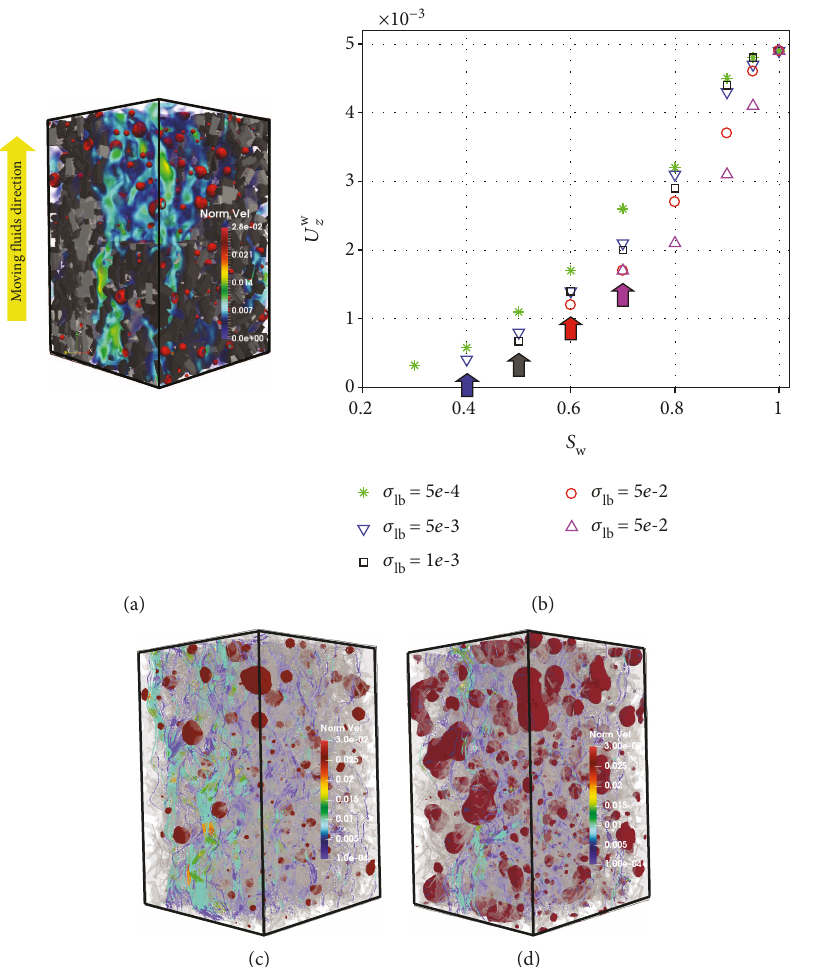
Figure 2: (a) Magnitude of the norm of total velocity throughout the porous medium (solid in back and gray) as well as non-wetting droplets (in red) at S nw = 0 05 and σ lb = 0 05 at a given time snapshot ( 3 × 10 5 iterations). (b) Mean seepage velocity, U continuous streamlines of the wetting phase. (c) and (d) Magnitude of the norm of seepage velocity (solids are rendered transparently in gray) and non-wetting droplets (in red) for S nw = 0 05 (left) and S nw = 0 20 (right) with σ lb = 0 05 at 3 × 10 5 iterations. For better visualization, not all streamlines are